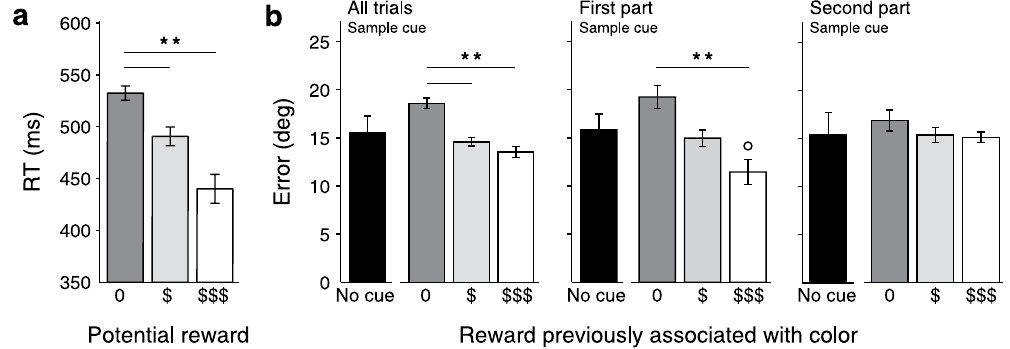
Figure 3. Results of Experiment 2. ( a ) Results of the color-reward association task of Experiment 2 averaged over all participants ( n = 8). Correct color reports were generally faster for colors associated with higher rewards. ( b ) Results of the working memory task of Experiment 2 ( n = 8). The error between the reported and the remembered orientation was smaller for stimuli surrounded by a ring in a color that previously predicted higher rewards. This effect was significant when all trials were analyzed together but strongly relied on the first half of the trials and the effect failed to reach significance in the second part of the experiment. Color cues were only presented in the sample phase, or not at all. Error bars represent within-subjects s.e.m.’s 88 . Asterisks indicate significance levels for pairwise comparisons between reward-cues ( ** p < 0.01). The open circle indicates a significant difference from the no cue condition ( p <